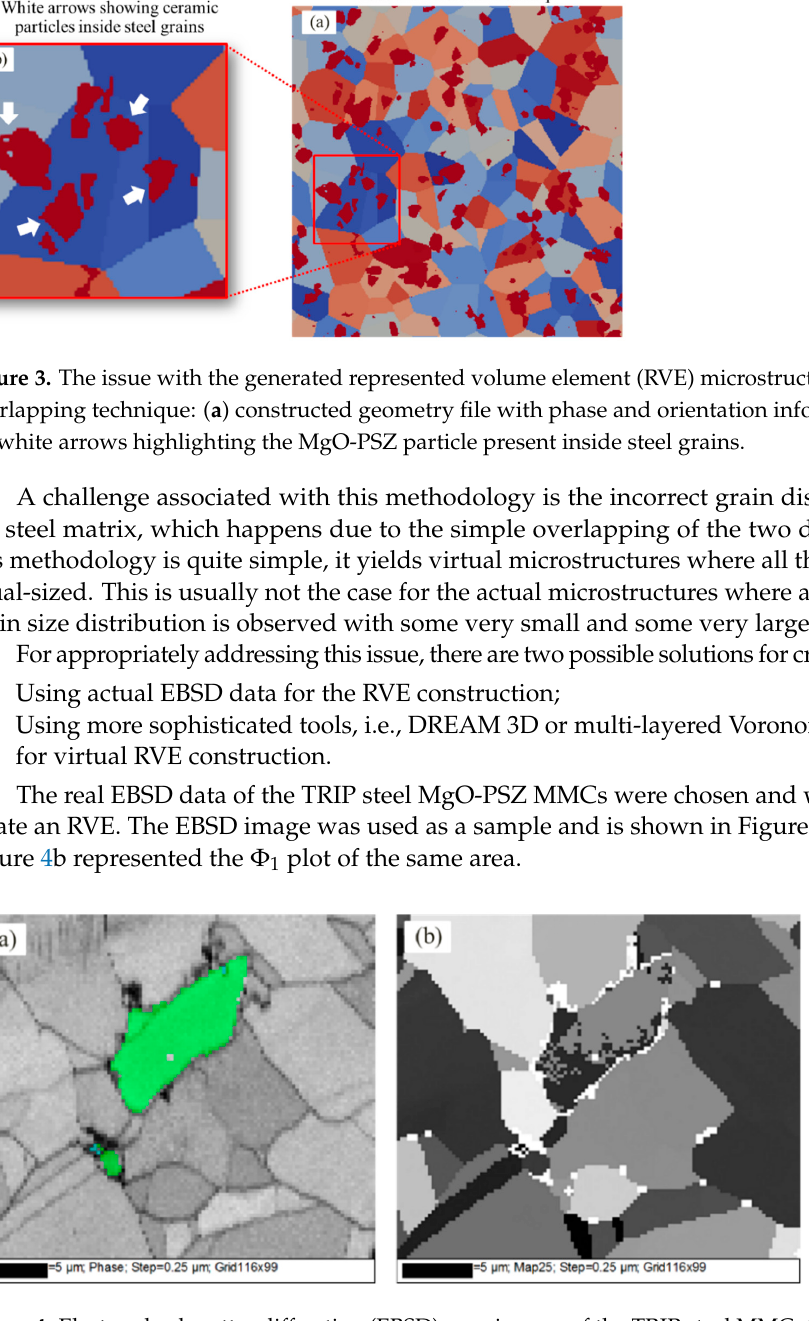
Figure 4. Electron backscatter diffraction (EBSD) map images of the TRIP steel MMC: ( a ) phase map (green—cubic MgO-PSZ greyscale—austenite in band-contrast); and ( b ) Φ 1